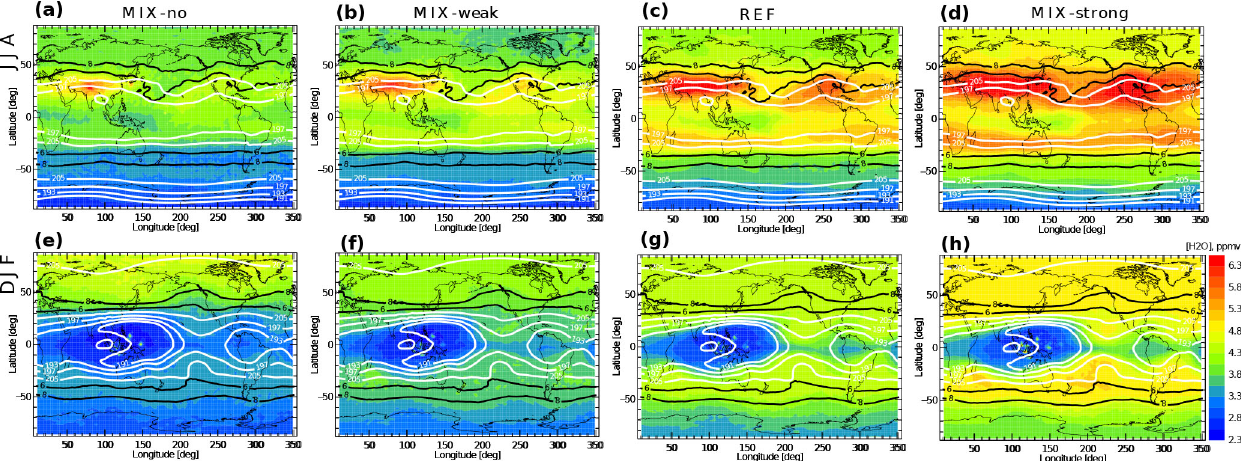
Figure 16. Seasonal mean water vapour distribution for 2011 from the CLaMS simulation without mixing (MIX-no) and the sensitivity simulations with non-vanishing mixing strength (MIX-weak, REF, MIX-strong) at the potential temperature level of 380K; DJF indicates winter (a–d) and JJA indicates summer periods (e–h) . Black lines indicate potential vorticity from ERA-Interim reanalysis data (6, 8PVU), and the white lines are temperatures (191, 193, 197, 205K) taken from ERA-Interim reanalysis